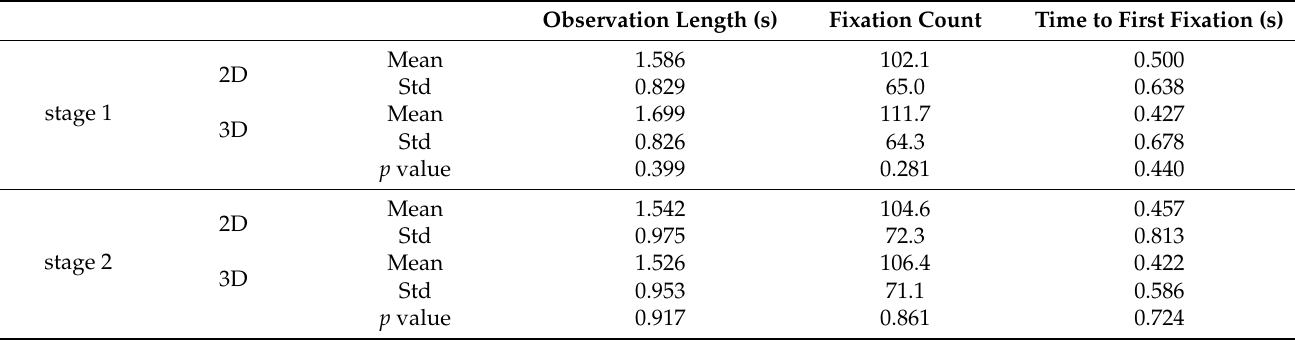
Table 4. Eye tracker result of 2D and 3D soothing dolls. (Data are derived from the sum of either AOI-1 or